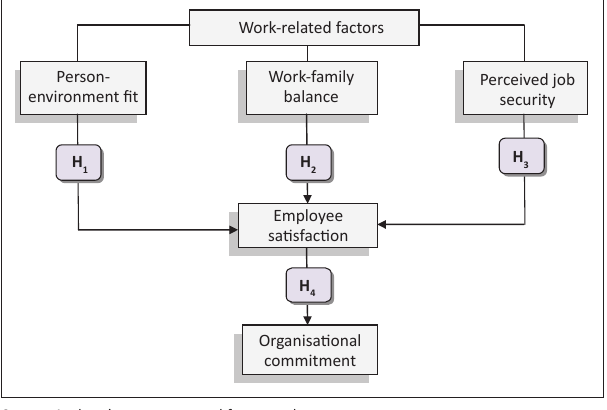
FIGURE 1: Conceptual